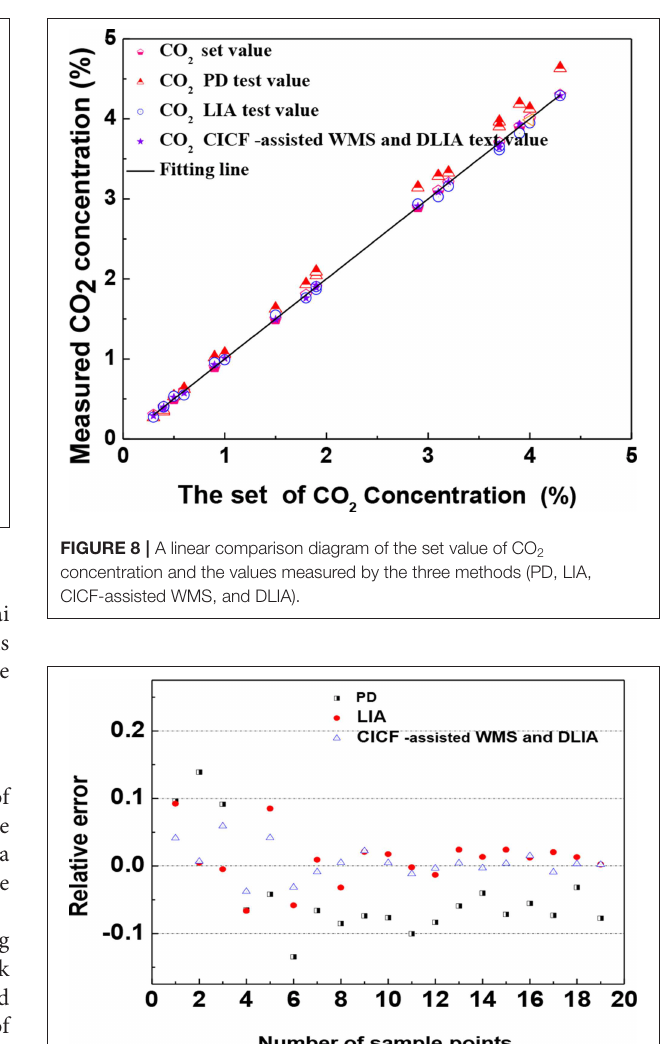
comparing the errors, the last test method has a smaller error and a better